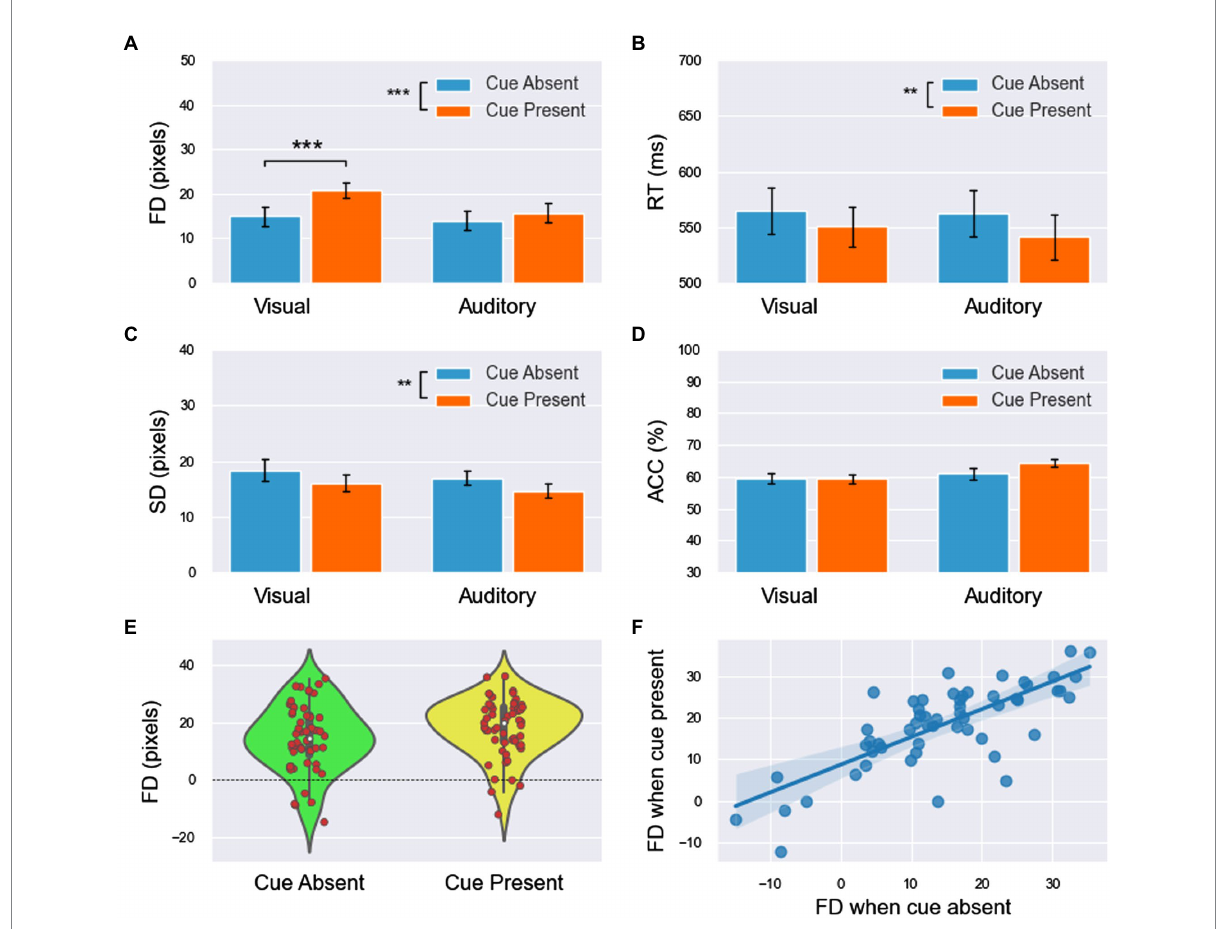
FIGURE 5 The results of forward displacement (FD, A ), response time (RT, B ), fitting standard deviation (SD, C ), and accuracy (ACC, D ) in experiment 3 (the main effect of modality is not labeled in the figure). (E) The cue shifted the distribution of FDs (including both visual and auditory block) to higher values. (F) The linear relationship of FDs between the cue-absent and cue-present conditions had a slope of less than 1. Similar to the results of experiment 2, it can be speculated that the effect of the cue had an upper limitation. All significance level markings are as follows: * p < 0.05, ** p < 0.01, and *** p <